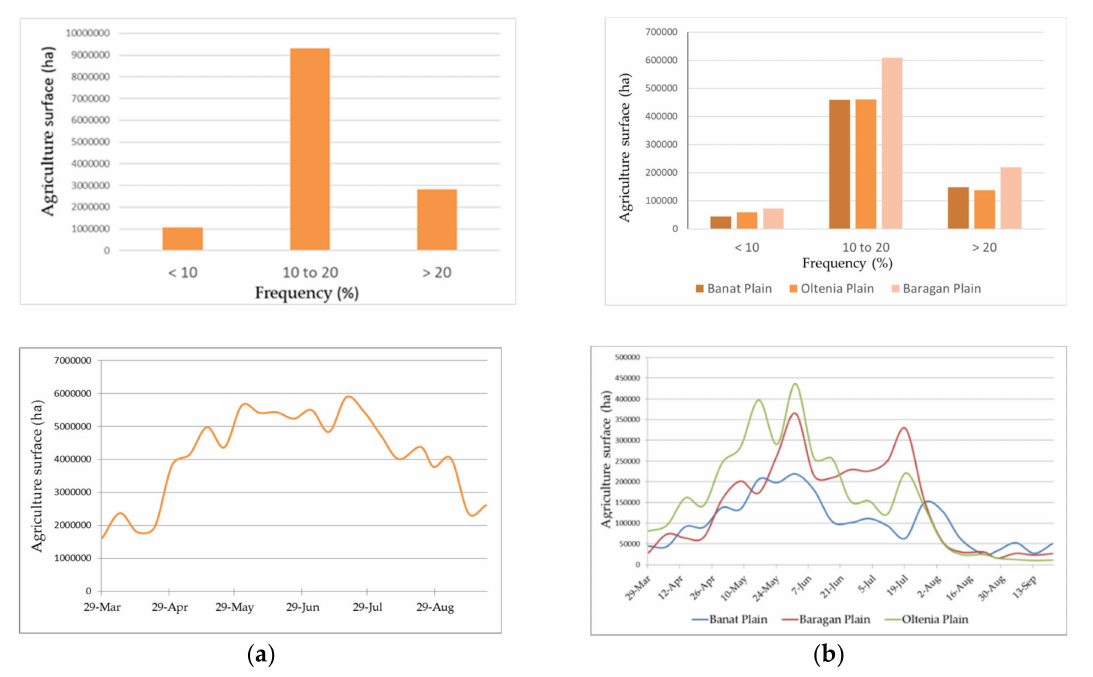
Figure 6. Agriculture drought frequency (%) and agricultural surface (ha) a ff ected in ( a ) Romania and ( b ) study areas